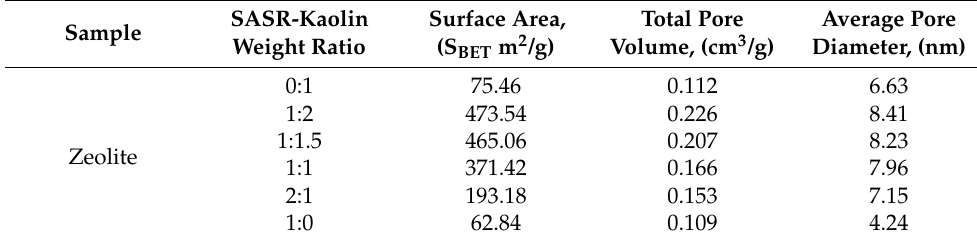
Table 2. The surface characteristics of the synthesized